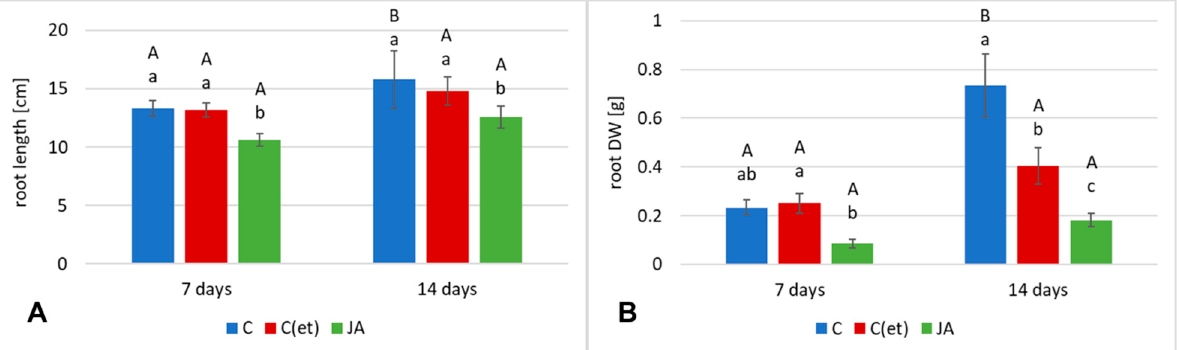
Figure 8. The length ( A ) and dry weight DW ( B ) of C. officinalis plant roots. C—control, C(et)—control samples treated with the adequate volume of 70% ethanol, JA—jasmonic acid-elicited samples. Bars which do not share a common letter are significantly different. Capital letters indicate significant difference in time between plants from the same treatment, lowercase indicate difference between treatments within certain time point.